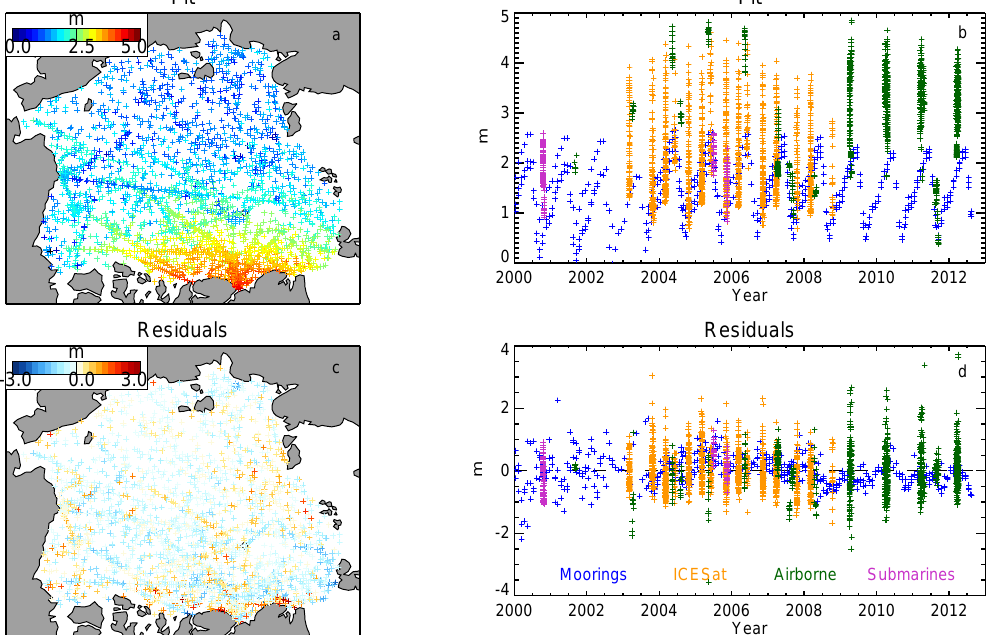
Figure 3. Fit to ice thickness observation data from the Arctic Basin for 2000–2012. (a) Map of ice thickness of the fit predictions at the data locations regardless of time; (b) the fit predictions at the data times regardless of location; (c) map of the residuals; (d) residuals as a function of time. The observational sources are grouped into four different types and color-coded as shown in (d)